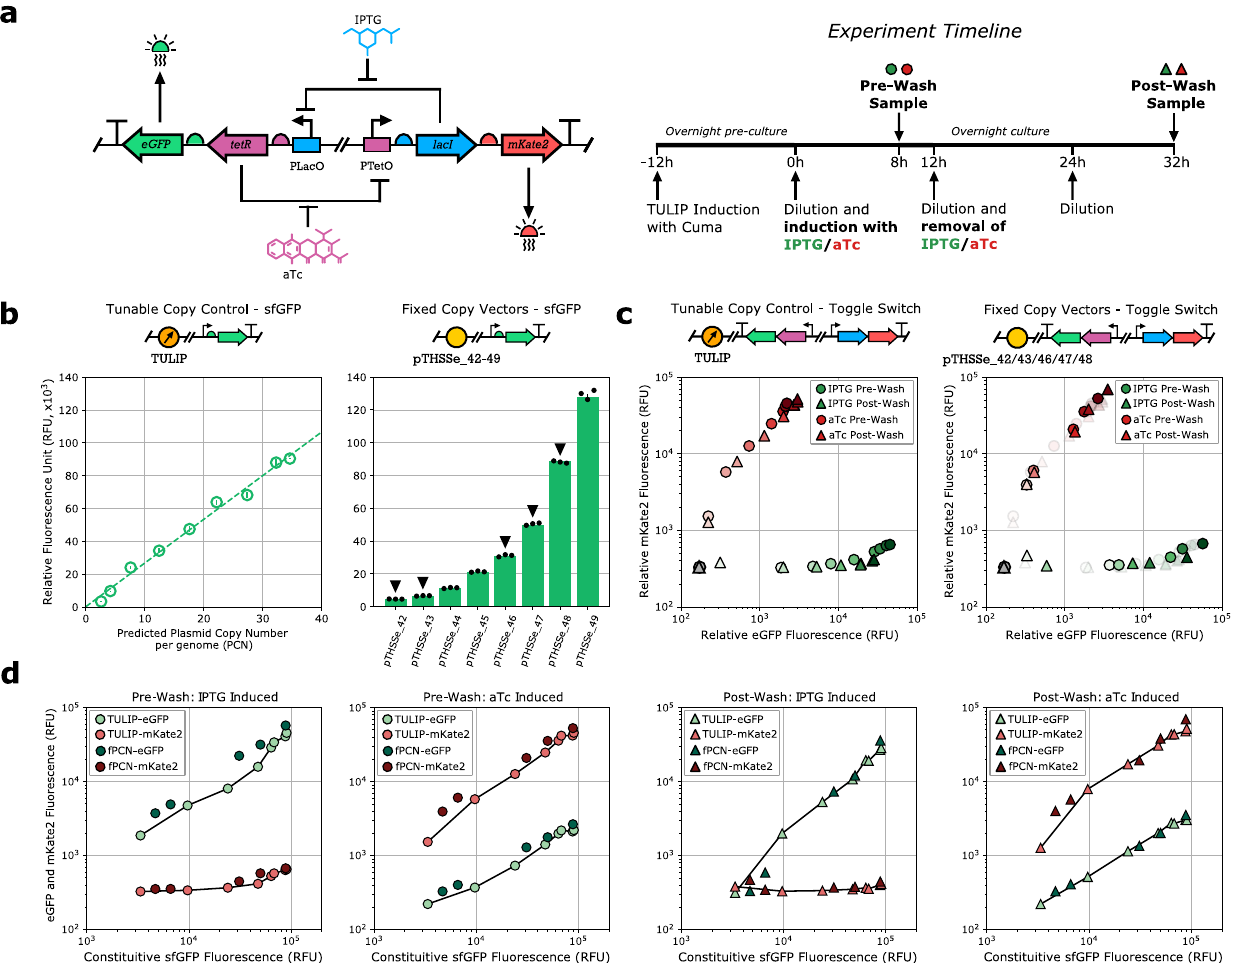
Fig. 7 | TULIP can facilitate gene circuit prototyping. LacI is co-expressed with mKate2, TetR is co-expressed with eGFP. Additional fl ow cytometry data and ana- lysis are provided in Supplementary Figs. 14 – 19. Circles and triangles denote pre- wash and post-wash samples, respectively. a Genetic layout of the toggle switch from ref.40 alongside with the experimental timeline for collecting samples sub- sequent to inductionwith IPTG/aTc(pre-wash, circles)and following their removal from the media (post-wash, triangles). b Expression of sfGFP from the empty backbone (proxy for PCN). PCN estimates for TULIP are obtained via qPCR experiments. Among plasmids in the fPCN collection, those indicated with black arrowheads were selected to harbor the toggle switch. c Behavior of the toggle